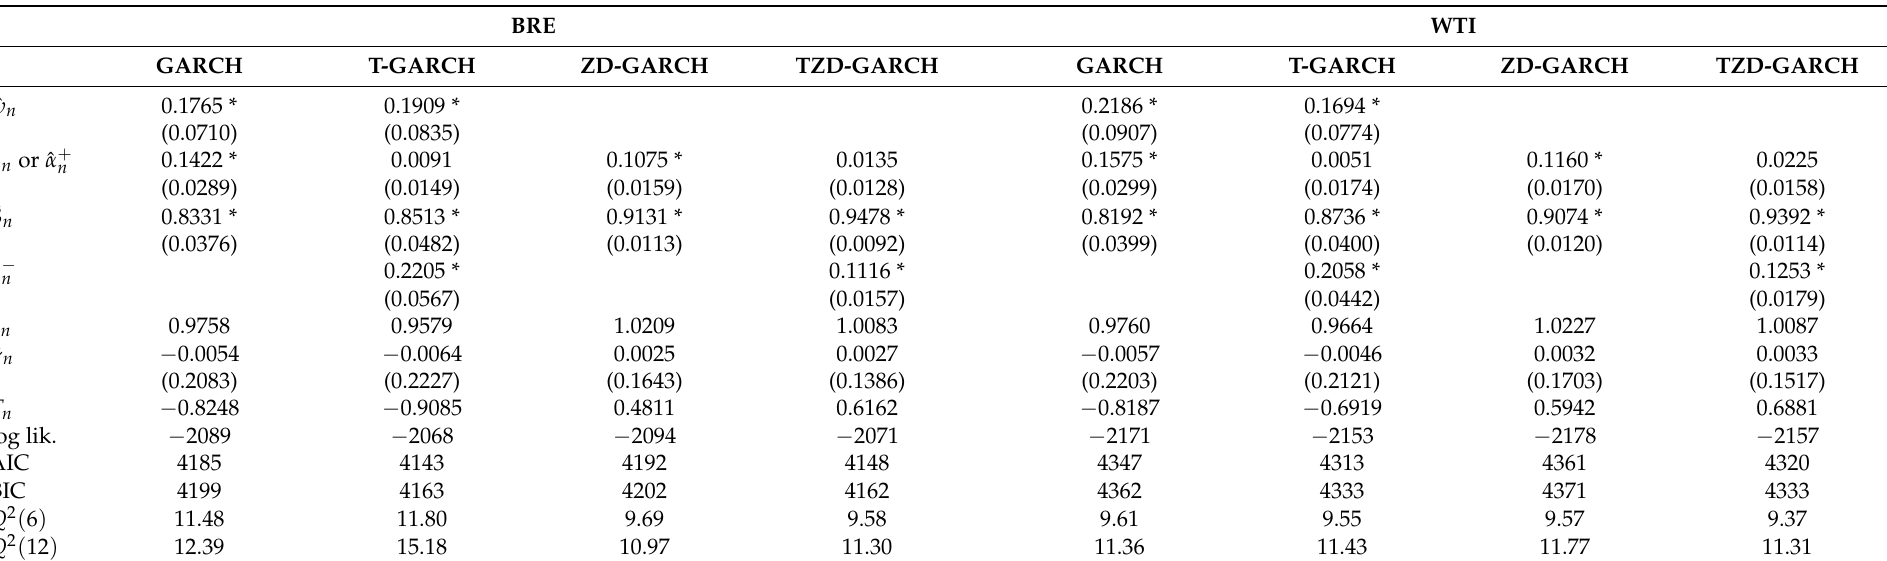
Table 6. Empirical results: BRE and WTI